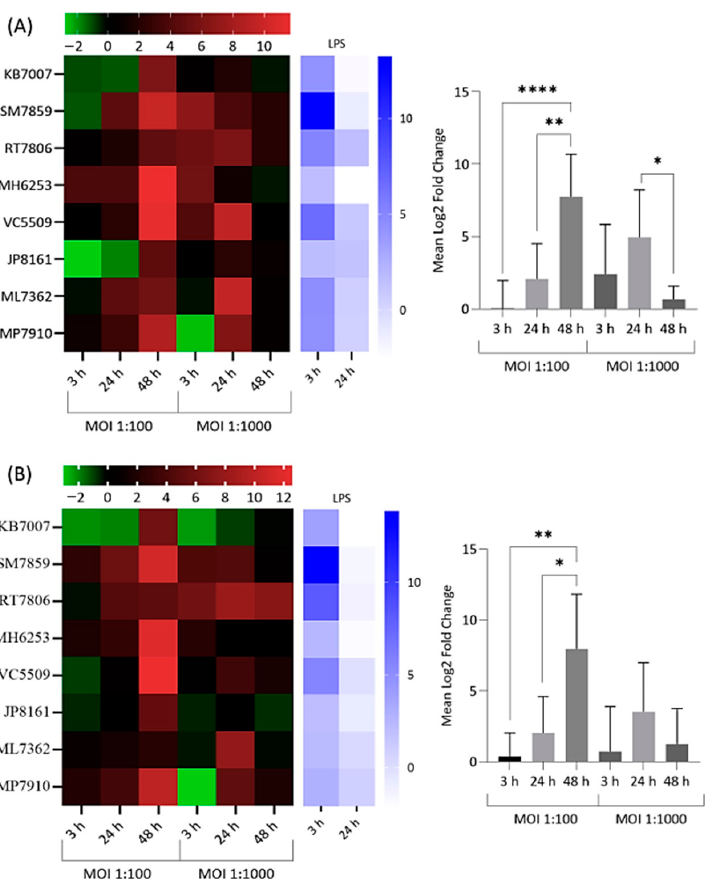
Figure 4. Heatmap and bar chart of log 2 fold expression changes for chemokine (C-C motif) ligand 3 (CCL3) ( A ) and chemokine (C-C motif) ligand 4 (CCL4) ( B ) in NP-derived disc cells infected with C. acnes . Heatmap values are individual changes (3 × biological replicates) from eight donor samples, while the bar chart represents average donor changes. Results with LPS positive controls are also shown. Top bars represent the log 2 fold-change scale * p < 0.05; ** p < 0.01; **** p < 0.0001.